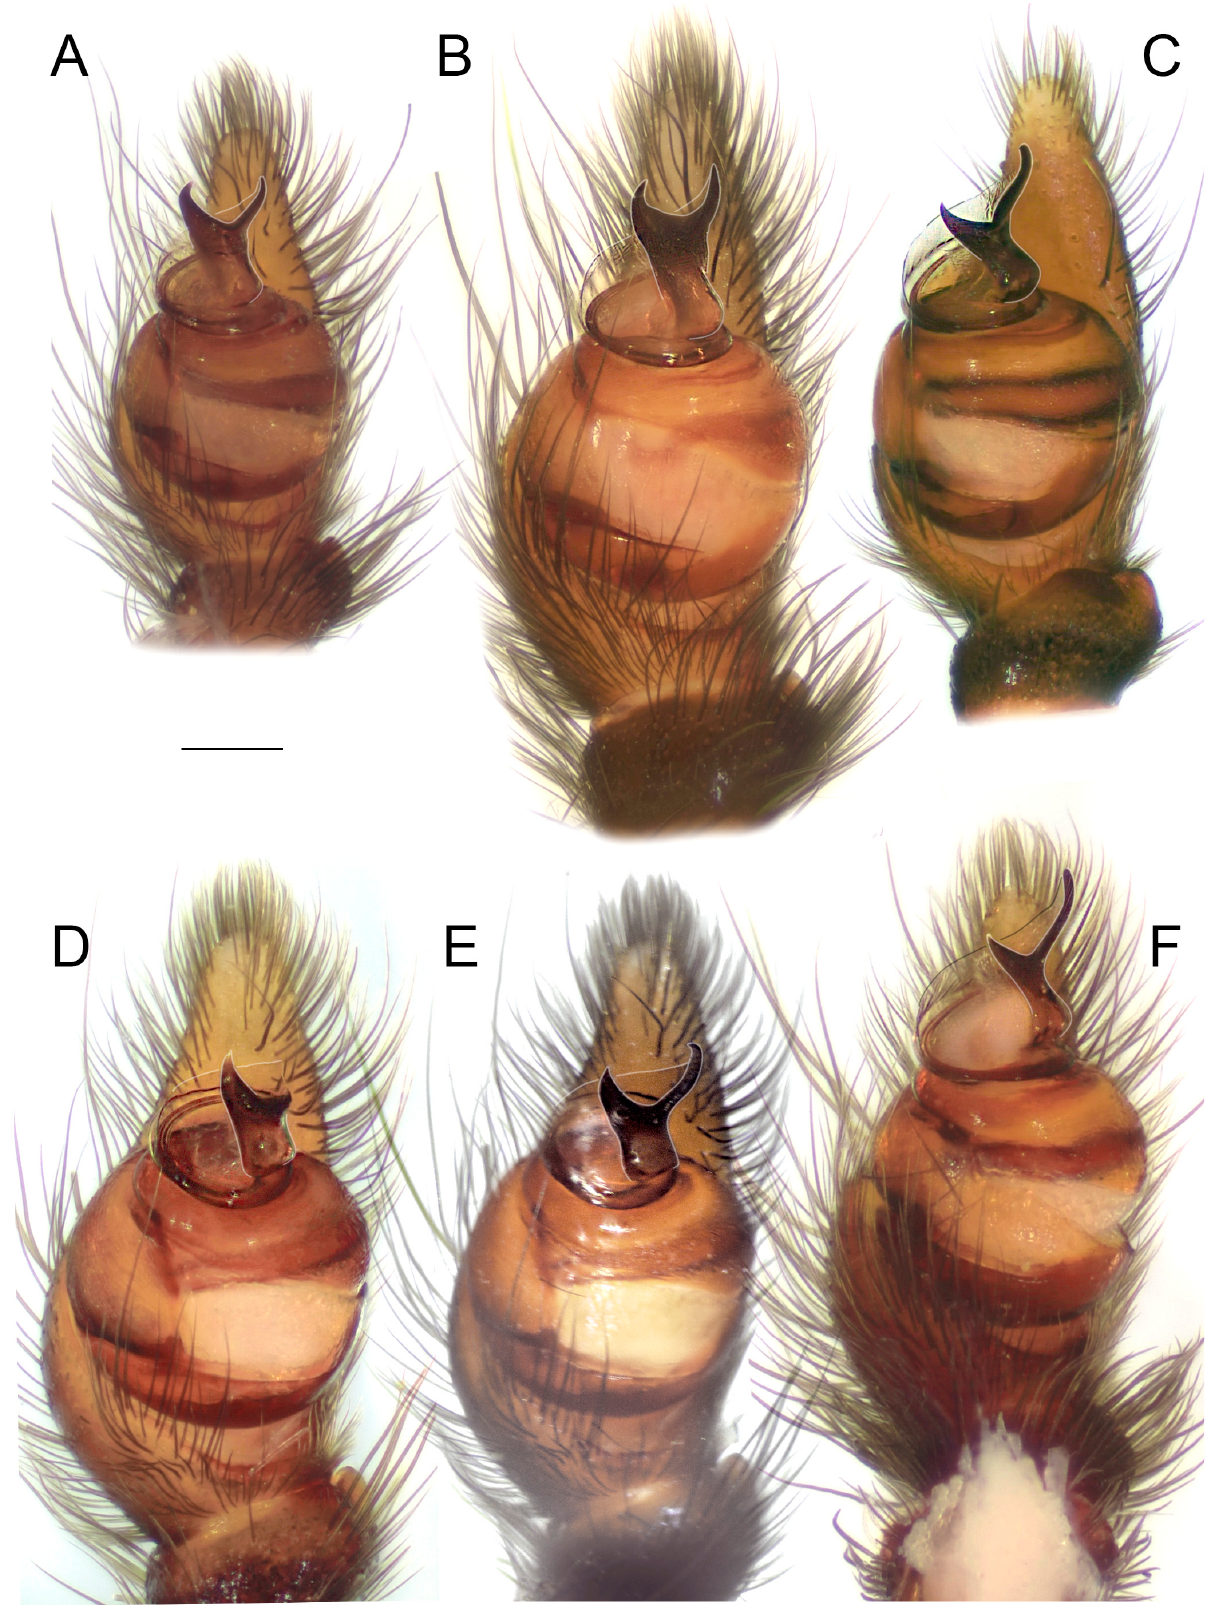
Figure 7. Male palps of five species of Loureedia (ventral view). ( A ) Loureedia phoenixi ; ( B ) L. jerbae ; ( C ) L. annulipes ; ( D ) L. maroccana , holotype (after conductor was broken); ( E ) L. maroccana , holotype (conductor still intact); ( F ) L. colleni . Scale bar: 0.25 mm.